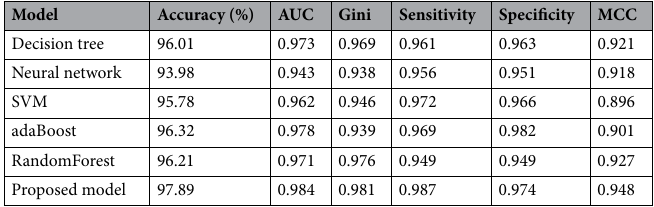
Table 5. Results in terms of accuracy and other performance metrics.